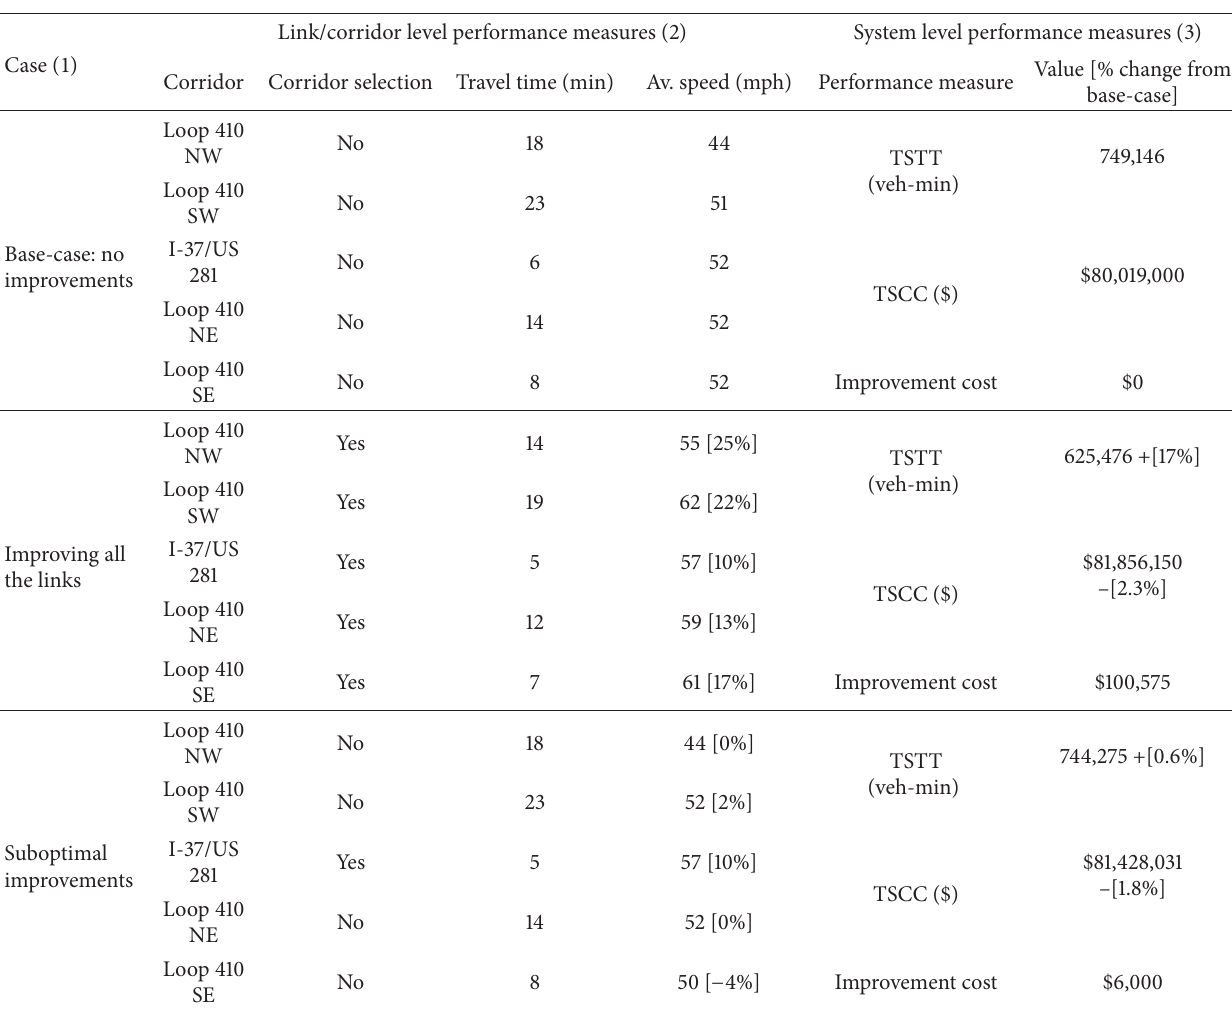
Table 2: Result of analysis of example